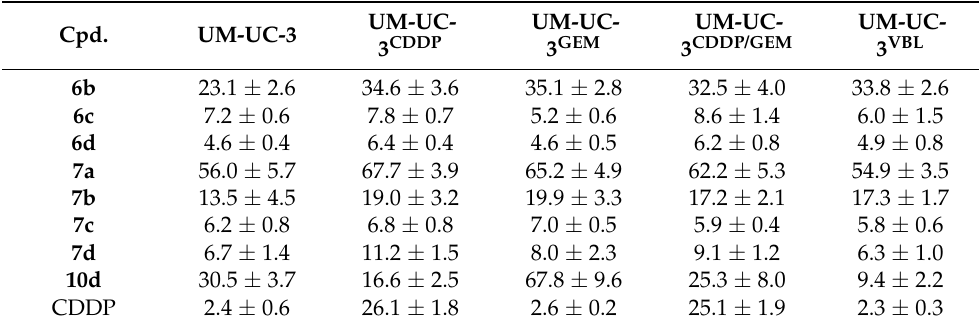
Table 4. Antiproliferative activity of studied compounds on urinary bladder transitional cell carci- noma cell line (UM-UC-3) and its variants resistant to cisplatin (CDDP), gemcitabine (GEM), both gemcitabine and cisplatin(CDDP/GEM) and vinblastine (VBL). Results are given as IC 50 ± SD ( µ M), with cisplatin (CDDP) used as reference.